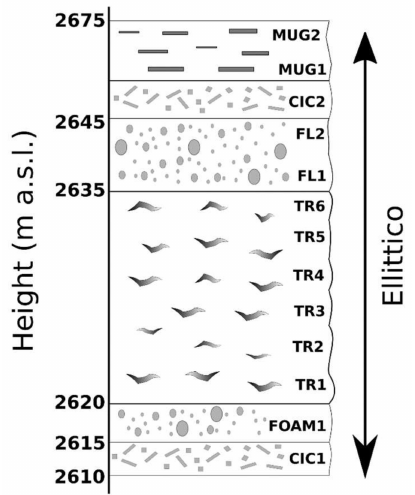
Figure 2. Schematic representation of the sampled sequence. The height (a.s.l.) is reported for each type of volcanic product (CIC = cicirara lavas, FOAM and FL = highly vesiculated lavas, TR = banded trachyandesites, MUG =